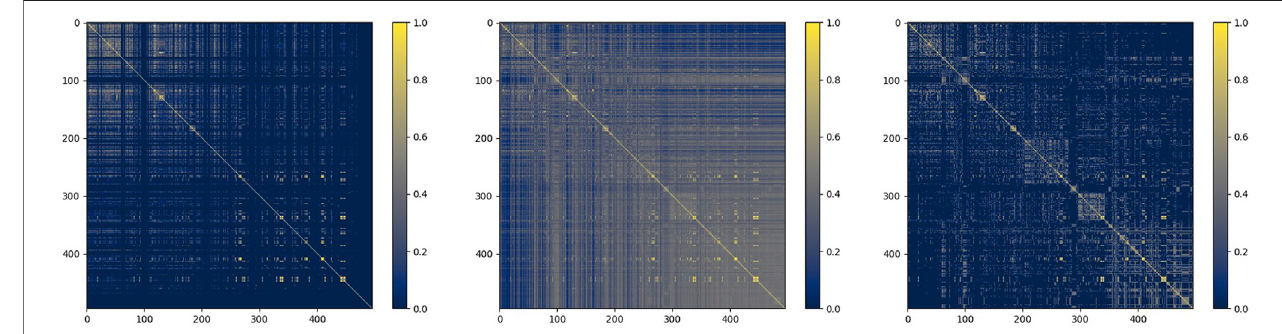
FIGURE 7 | miRNA function similarity, similarity after fusion, and similarity after fi ltering.